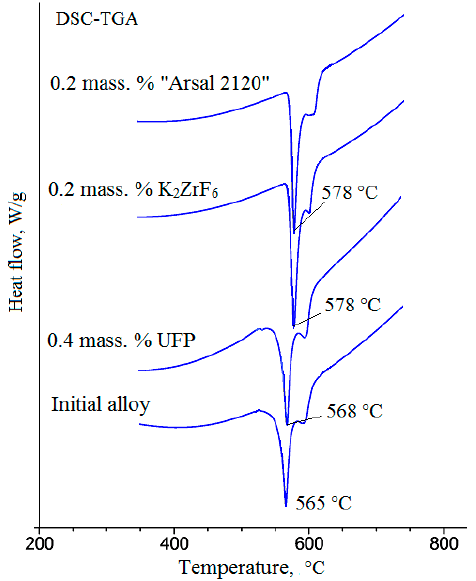
Figure 6. DSC curves of cooling of Al-7%Si with different modifying compositions at a heating temperature of 10 °C/min.